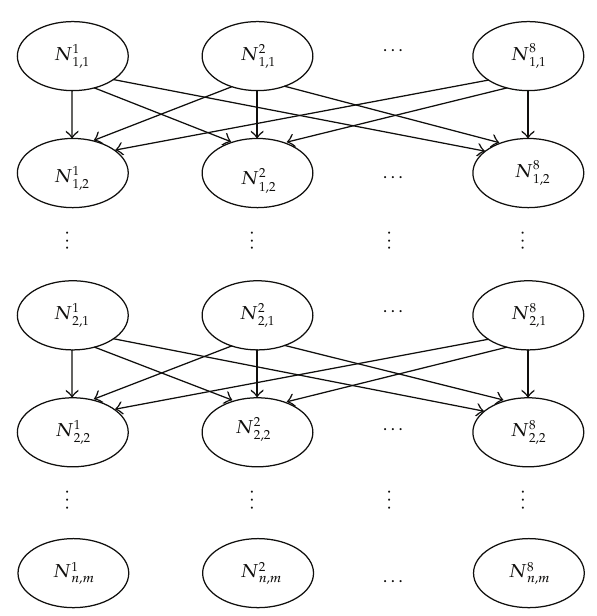
Figure 1: The structure of the Bayesian network used in